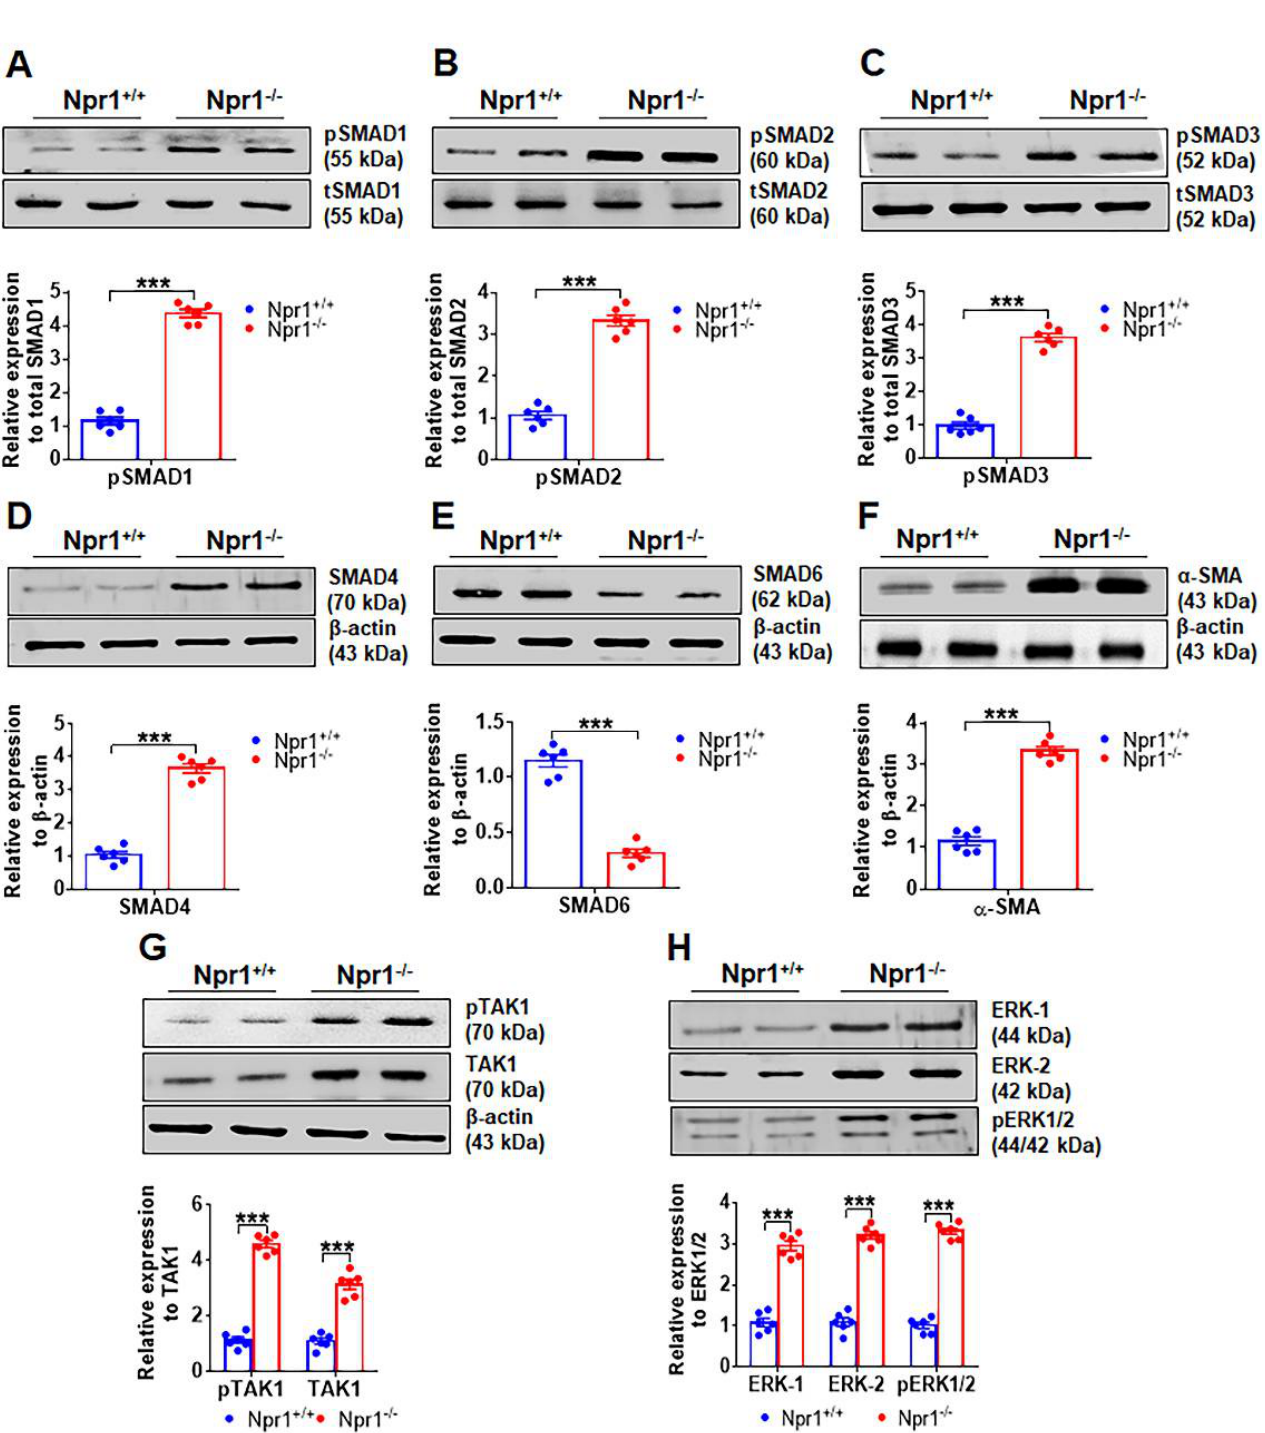
Figure 2. Analysis of the protein levels of different SMAD and key fibrotic markers in the heart tissues of male Npr1 gene knockout mice: representative Western blots showing the levels of pSMAD-1, pSMAD-2, pSMAD-3, SMAD-4, SMAD-6, α -SMA, pTAK1, and pERK 1/2 proteins in the heart tissues of Npr1 mice, respectively (panels ( A – H )). The densitometry analysis of proteins was normalized to total SMAD proteins and/or β -actin protein levels. Values are expressed as means ± S.E. (n = 6 animals in each group). Statistical significance is expressed as *** p < 0.001, Npr1 +/+ (2-copy) vs. Npr1 − / − (0-copy). In panels ( A – F ), Western blot was performed for the cytosolic extract and in panels ( G , H ), whereas Western blot was performed for both cytosolic and nuclear extracts.